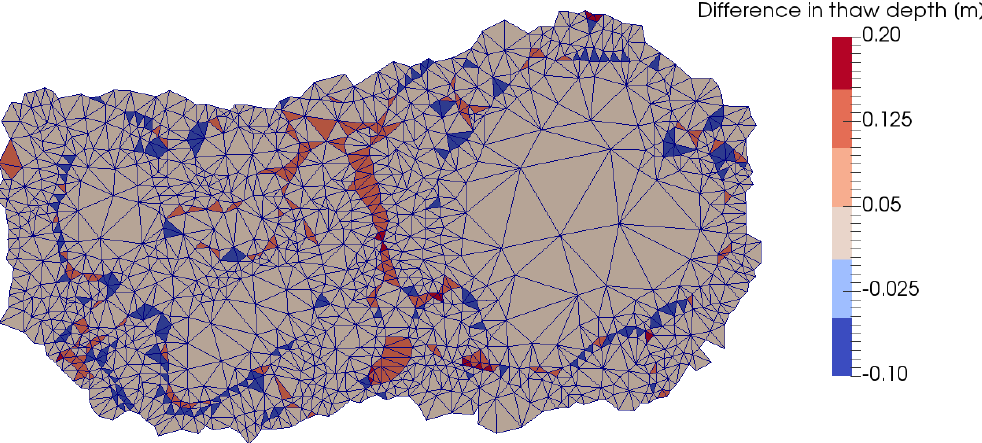
Figure E6. Difference in maximum thaw depth between 1-D and 3-D simulations. A positive bias indicates higher thaw depth in 1-D simulations compared to 3-D models, while negative values indicate lower thaw